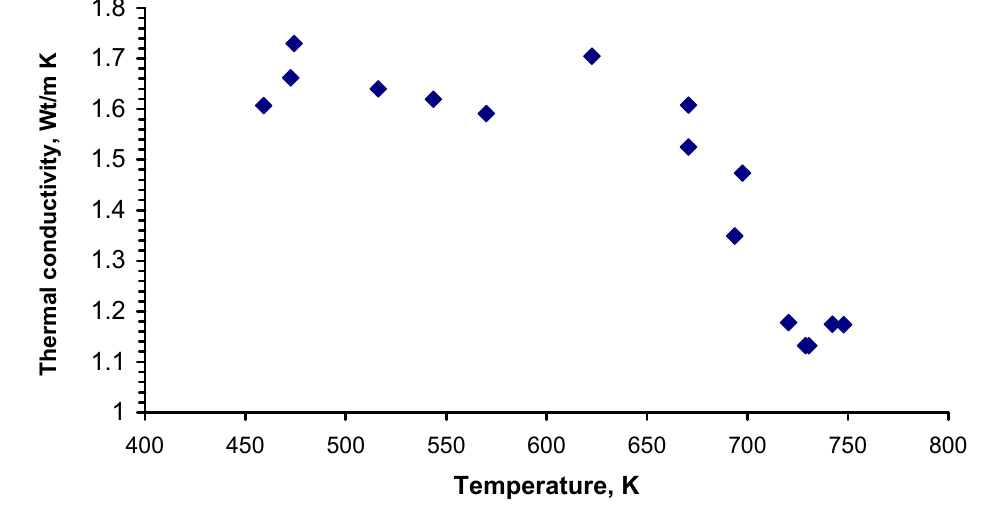
Figure 4. Thermal conductivity of the 66LiF-34BeF 2 mixture. Table 1. Values of thermal diffusivity (a), density; (ρ), heat capacity; (C p ); and thermal conductivity (λ) of the Li 2 BeF 4 compound.